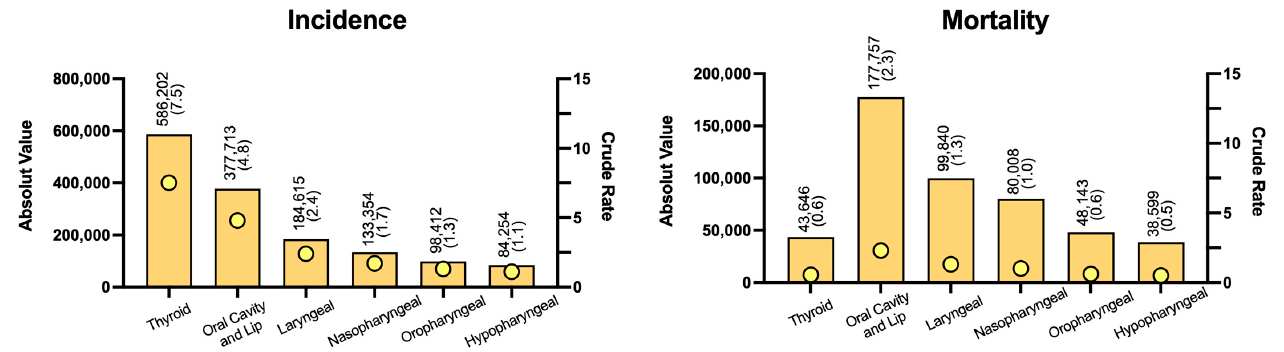
Figure 1. Incidence, mortality, and respective crude rates of the most prevalent subtypes of Head and Neck Cancer (HNC) worldwide in 2020, according to the Global Cancer Observatory (GCO), as determined by the International Agency for Research on Cancer (IARC) .